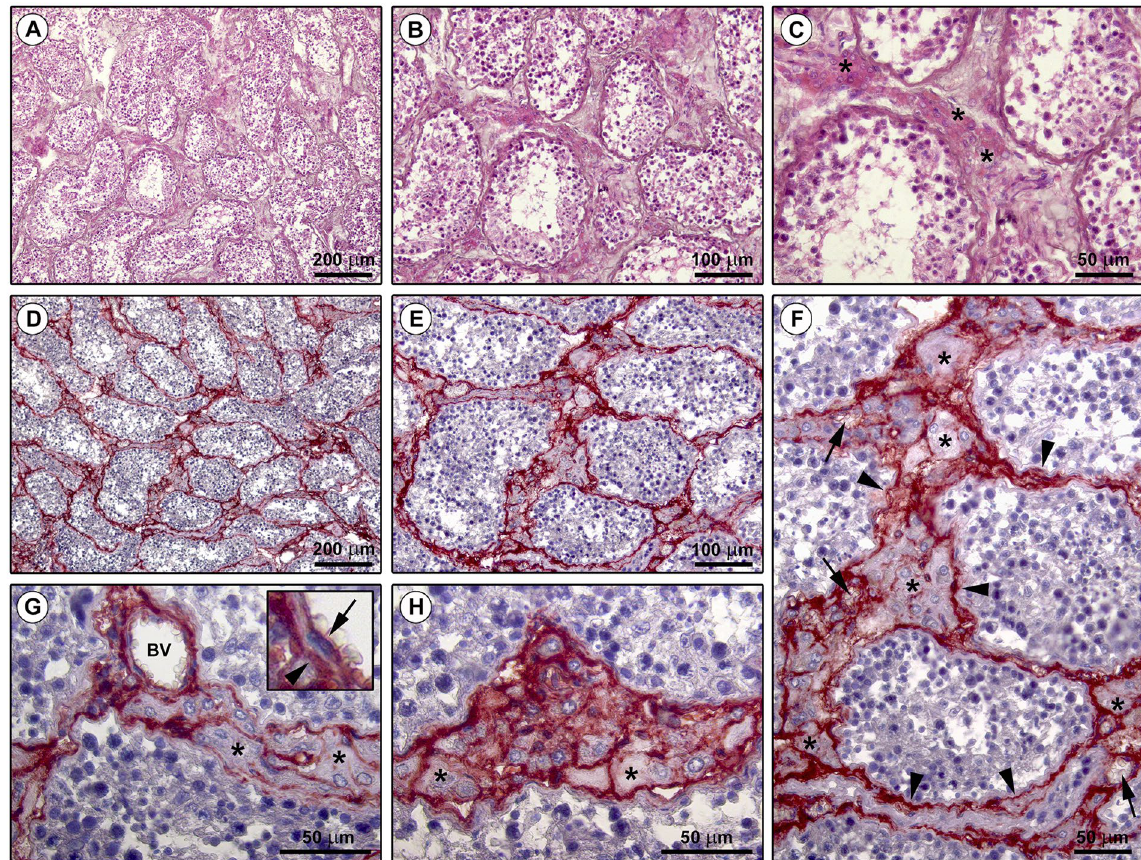
Figure 1. Light microscopy photomicrographs of human testis sections. ( A – C ) Representative photomicrographs of hematoxylin and eosin-stained tissue slides. Seminiferous tubules cut in various planes of section are surrounded by the peritubular and intertubular connective tissue ( A,B ). Note the optimal preservation of the peritubular and intertubular stroma, as testified by the presence of typical clusters of testosterone-secreting Leydig cells displaying an extensive eosinophilic cytoplasm (asterisks) in close vicinity to blood microvessels and embedded in an extracellular matrix ( C ). ( D – H ) Representative photomicrographs of testicular sections subjected to CD34 immunoperoxidase-based immunohistochemistry with hematoxylin counterstain. CD34-positive interstitial cells (red-stained) form a continuous network throughout the peritubular and intertubular stromal spaces ( D,E ). At higher magnification, the CD34-positive interstitial cells exhibit an elongated/spindle morphology with long and thin varicose cytoplasmic prolongations surrounding the seminiferous tubules (arrowheads in F ), as well as the Leydig cells (asterisks in F – H ) and blood microvessels (arrows in F ) in the intertubular stroma. CD34 immunoreactivity is observed also in endothelial cells of blood vessels (BV); a higher magnification of CD34-positive endothelial cells lining the vessel lumen (arrow) and CD34-positive interstitial cells bordering the abluminal side of the vessel basement membrane (arrowhead) is shown in the inset ( G ). The CD34-positive interstitial cells constitute a complex reticular network around the Leydig cells (asterisks) in the intertubular stromal tissue ( H ). Scale bar: 200 µ m ( A,D ), 100 µ m ( B,E ), 50 µ m ( C,F–H